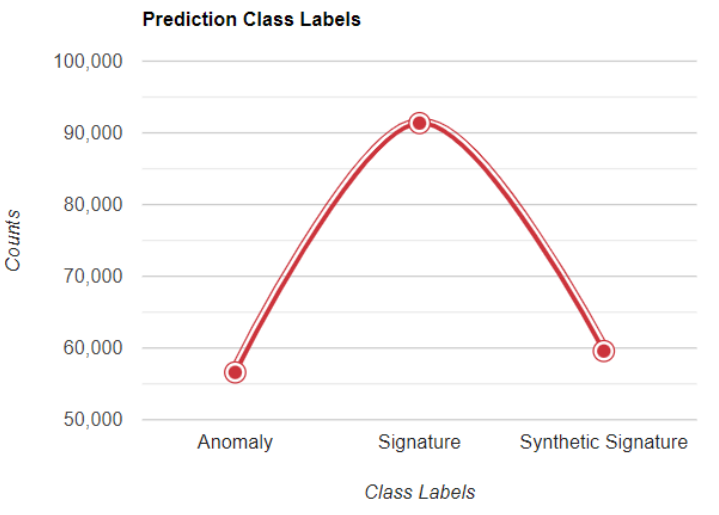
Figure 3. The Prediction Class Labels.